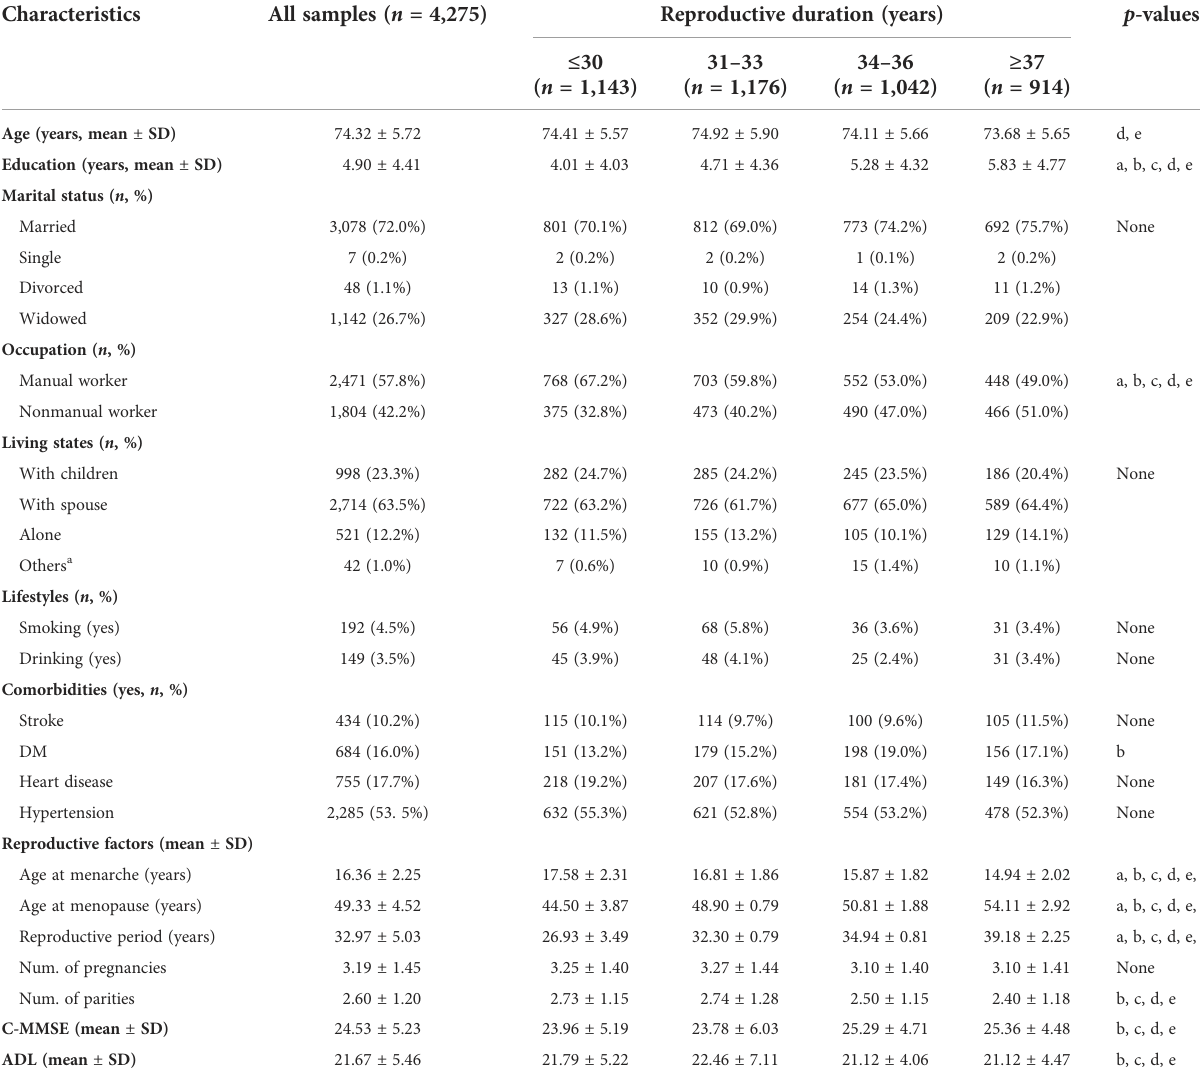
TABLE 1 General characteristics of